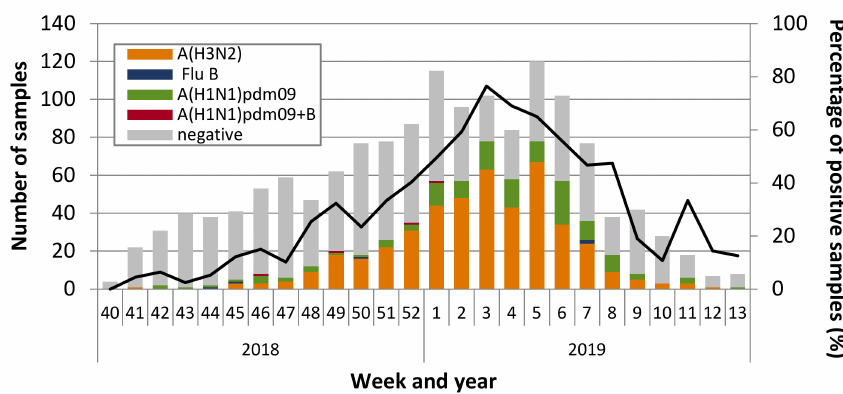
Figure 1. Distribution of influenza types / subtypes by week, among influenza-like illness (ILI) patients presenting to sentinel clinics of the Israel Influenza Surveillance Network (IISN), Israel, September 30, 2018 to March 30,